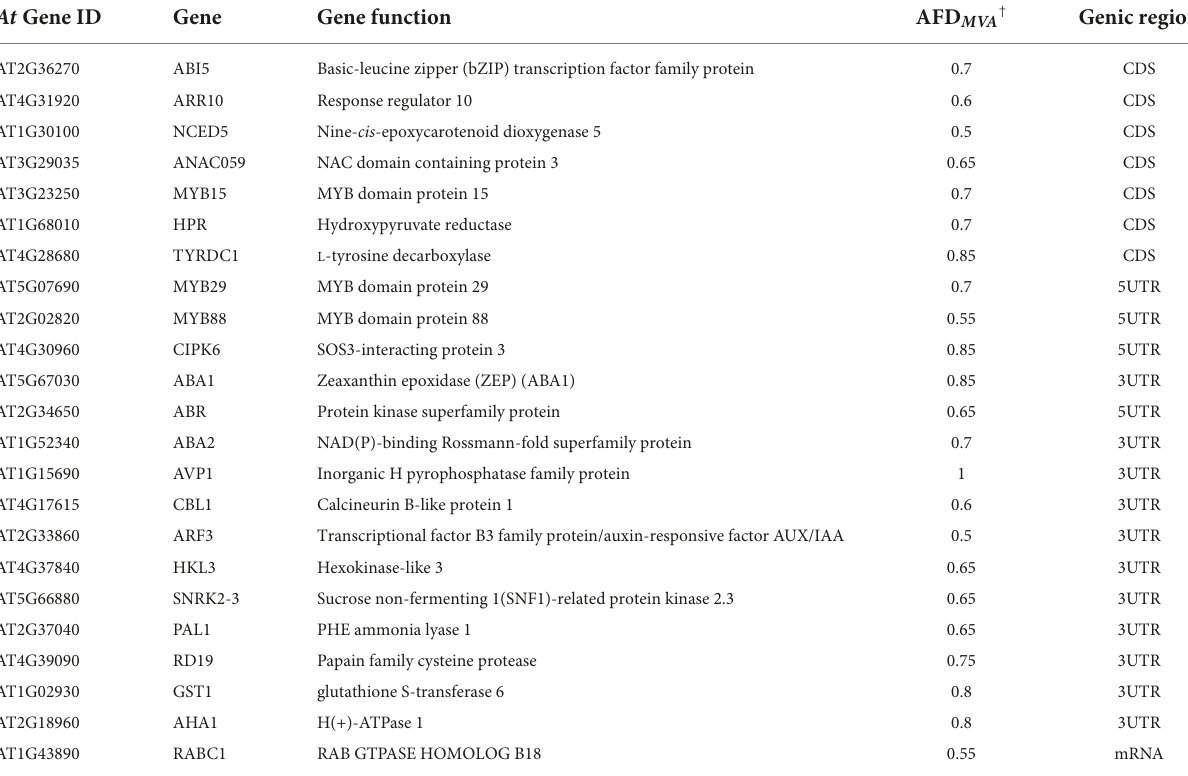
TABLE 3 Loci associated with response of plants to water deprivation.